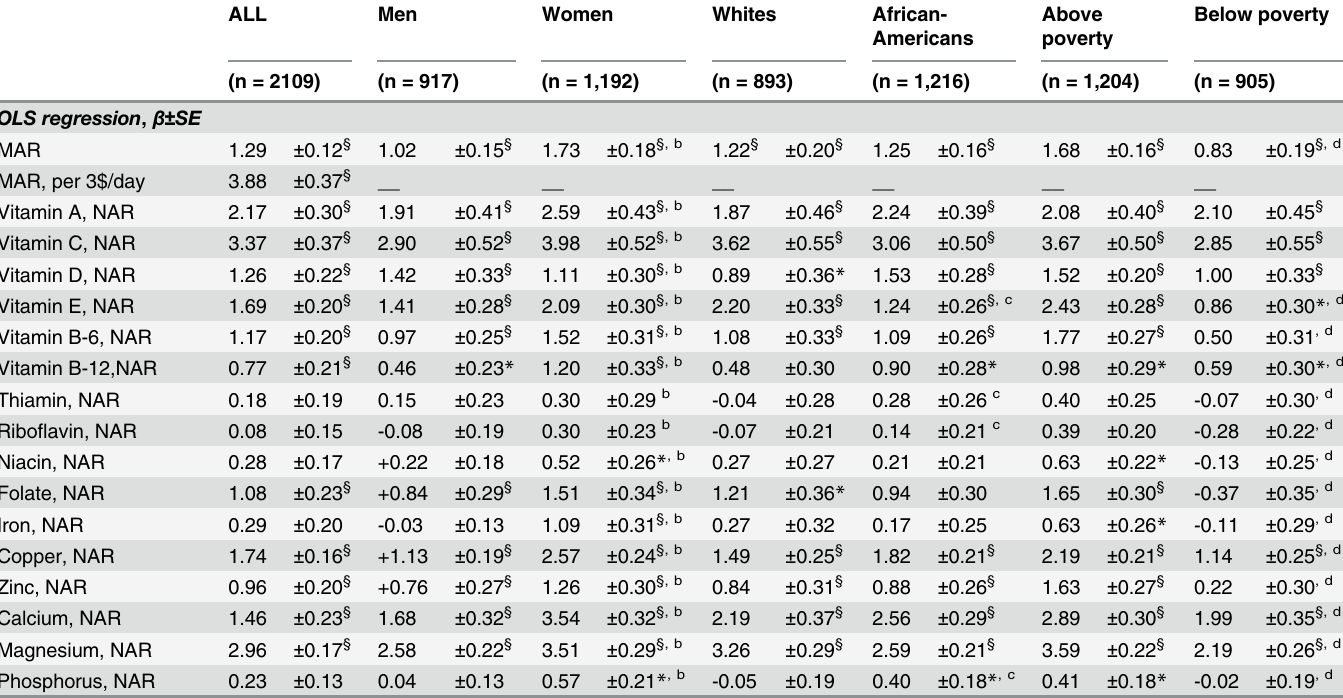
Table 5. Association between monetary value of reported diets ($/day) and mean adequacy ratio (MAR) and component nutrient adequacy ratios (NAR): findings from multiple OLS regression models a .